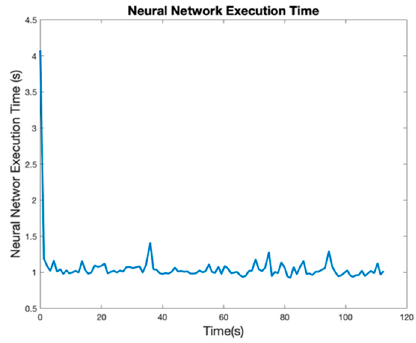
Figure 16. The Neural Network execution time in the CPU.